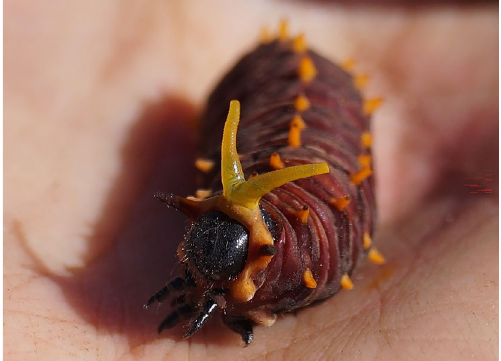
Figure 1. Larval individual of Battus polydamas archidamas , fully exposing its